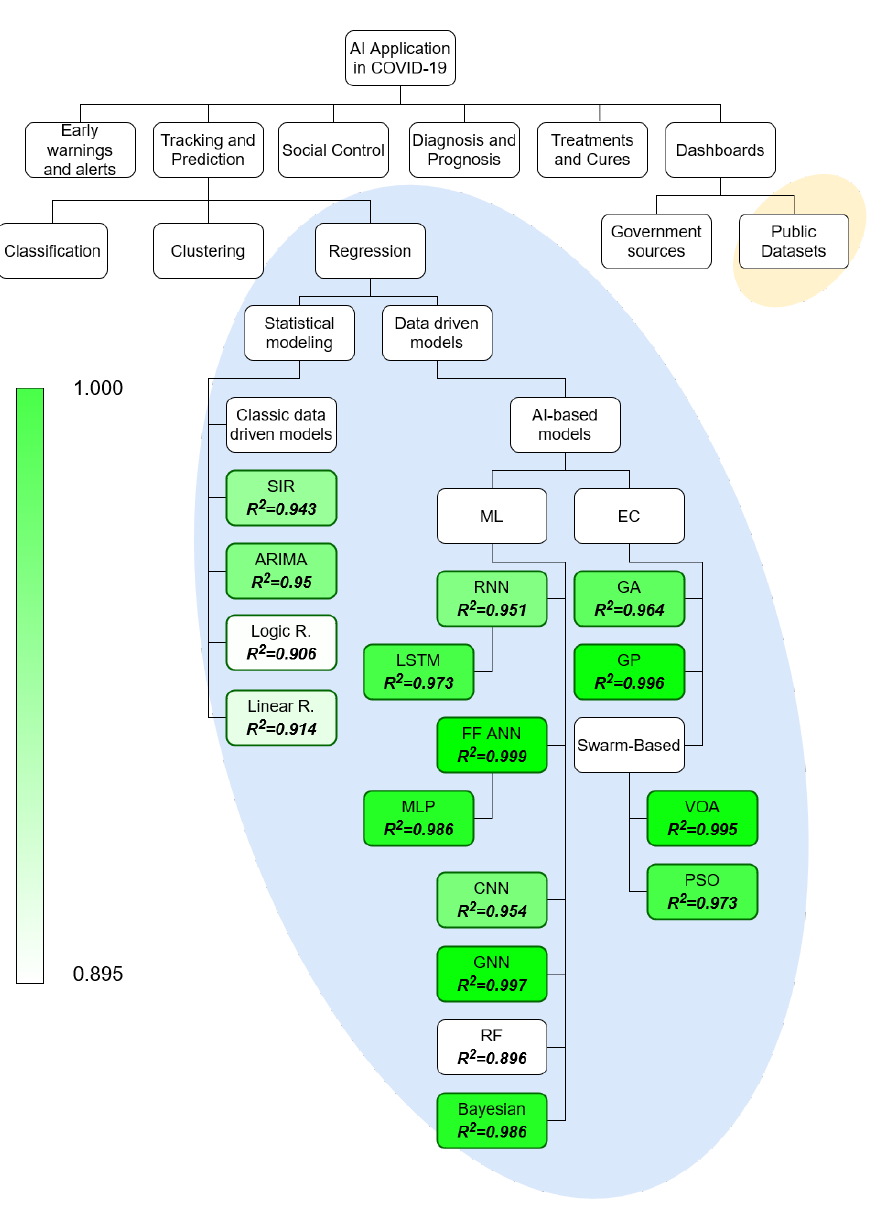
Figure 11. Taxonomy of the AI research in the field of COVID-19, with the best results for the reviewed research subjects given inside the taxonomy